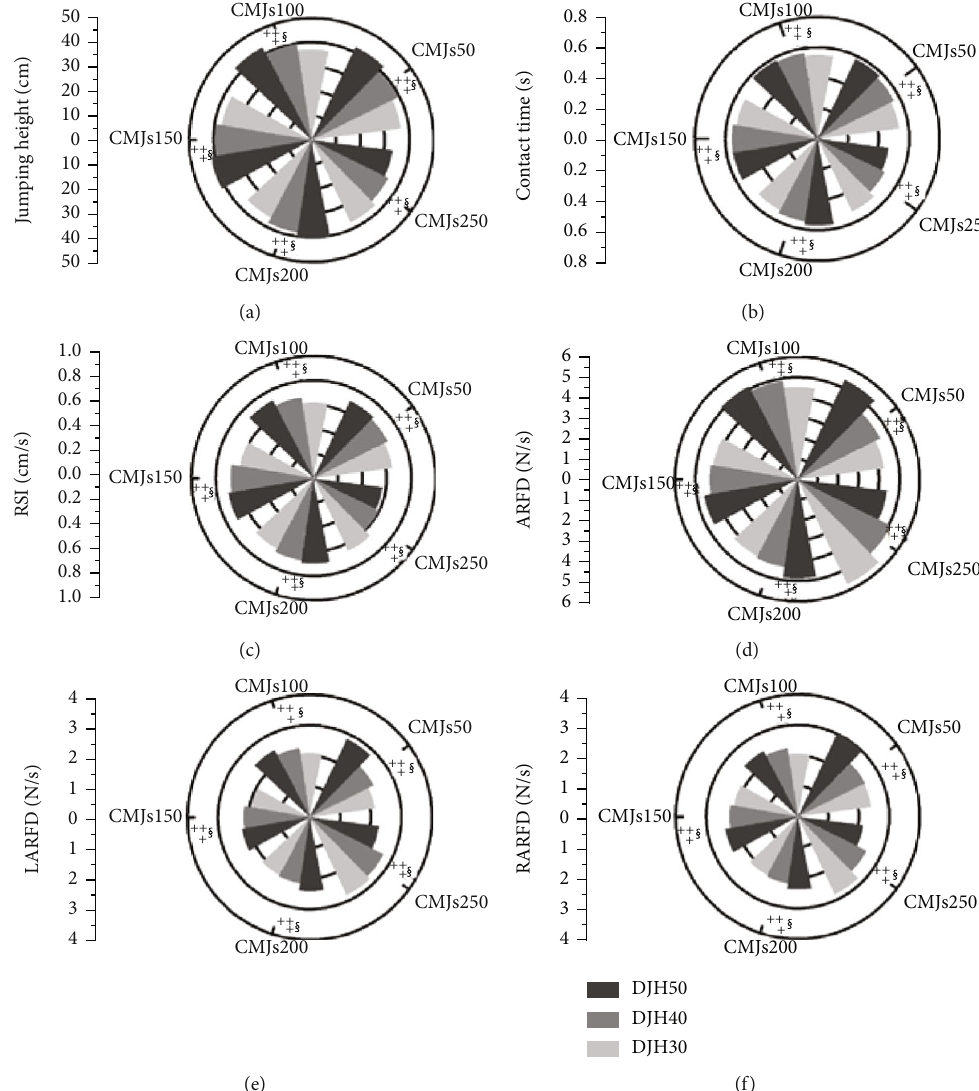
Figure 2: (a – f) Represent the JH, CT, RSI, ARFD, LARFD, and RARFD during countermovement jumps from three heights at CMJs50, CMJs100, CMJs150, CMJs200, and CMJs250. CMJ: countermovement jump; JH: jump height; CT: contact time; RSI: reactive strength index; ARFD: both feet average rate of force development; LARFD: left foot average rate of force development; RARFD: right foot average rate of force development; DJH30: drop jump from 30 cm drop heights; DJH40: drop jump from 40cm drop heights; DJH50: drop jump from 50cm drop heights. † indicates a signi fi cant di ff erence from DJH30; ‡ indicates a signi fi cant di ff erence from DJH40; § indicates a signi fi cant di ff erence from DJH50 ( p < 0 : 05